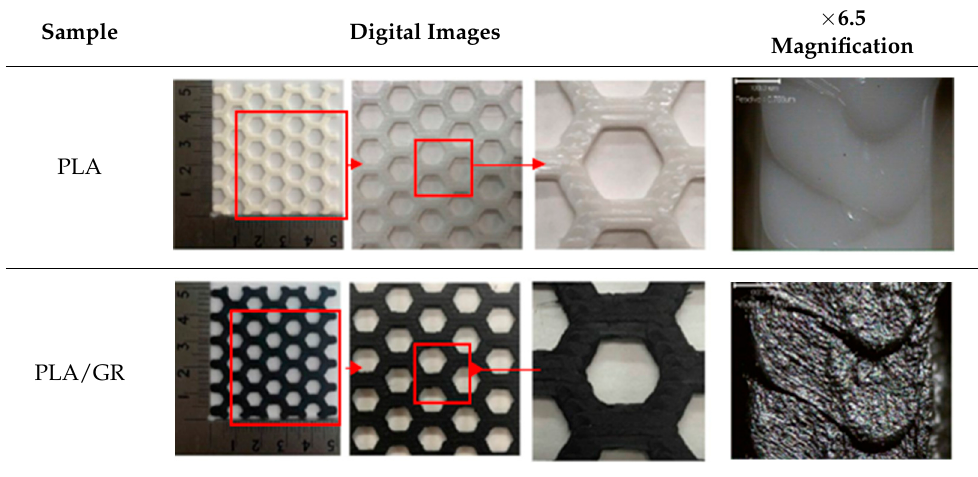
Table 3. Morphology of 3D-printed honeycomb samples by transmission electron microscopy [109]. PLA–GR = poly(lactic acid)–graphene. Reproduced with permission from Springer.